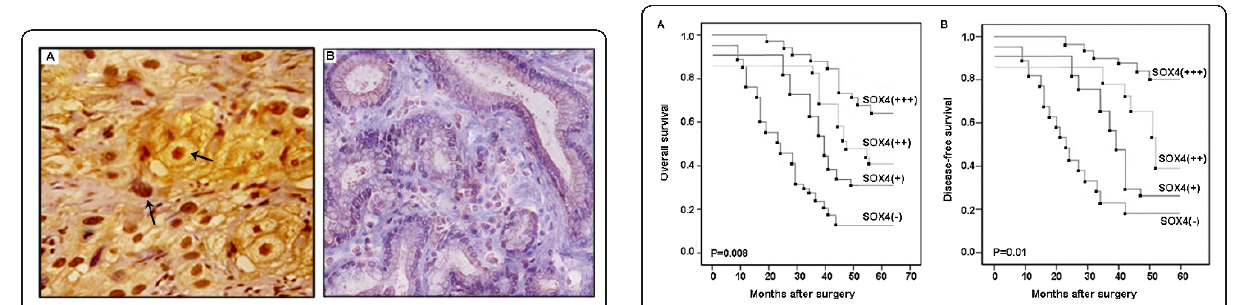
Figure 1 Immunohistochemical staining of SOX4 expression in PGC . Commercially available mouse-antihuman monoclonal antibody against SOX4 was used to stain the paraffin section. A, Strong cytoplasmic and nuclear expression of SOX4 was detected at the tumor cells of PGC tissues (original magnification × 400); B, SOX4 was negative in normal epithelium of gallbladder (original magnification × 400).